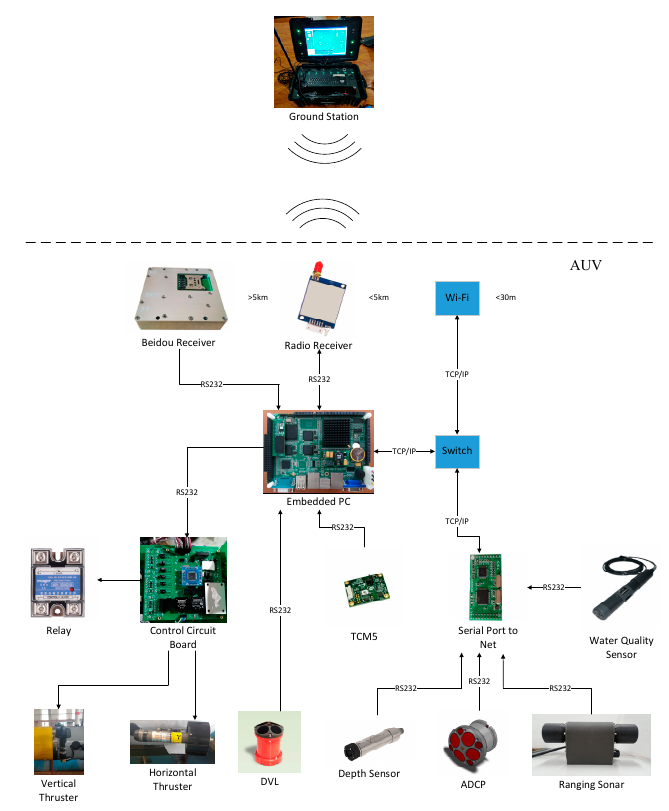
Figure 3. Hardware architecture of the AUV.